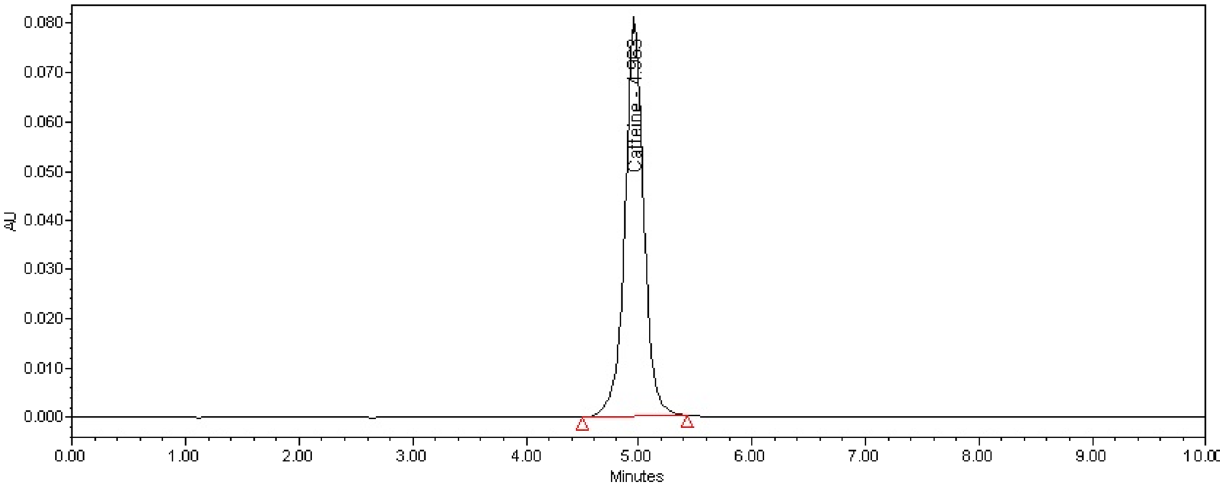
Fig. 2 Representative chromatogram showing caffeine peak from standard working solution. Stationary phase: Symmetry C-18 column; Mobile phase: Ammonium acetate buffer (10 mM, pH 4.0): acetonitrile (90:10 v/v); Flow rate: 1 ml/min and detector wavelength: 220